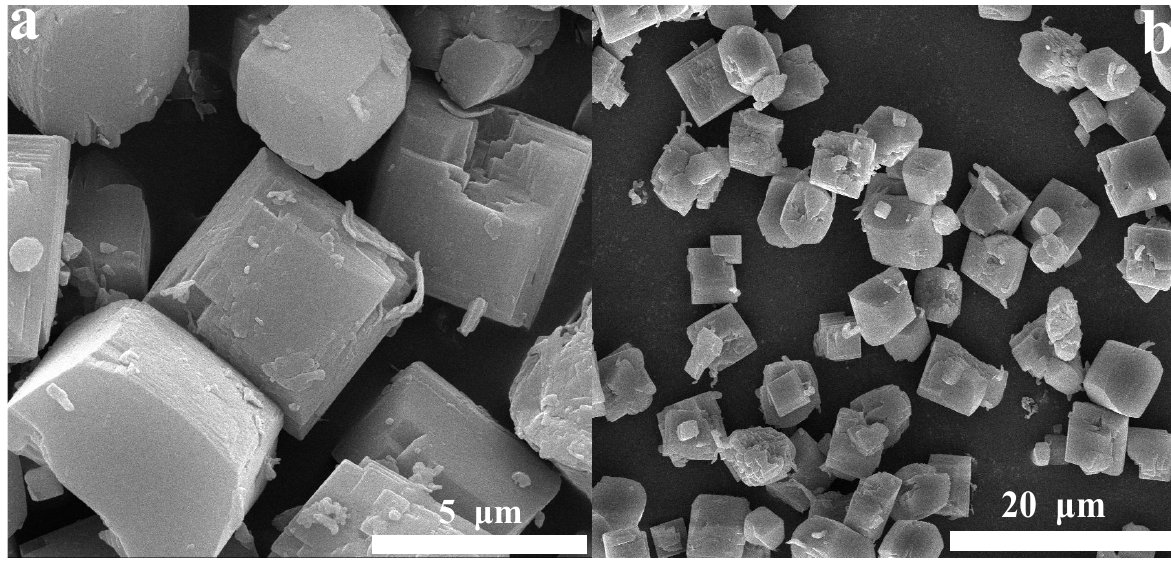
Figure 2. SEM images of ( a ) ETS-10 zeolite and ( b ) Co/ETS-10 catalyst sample.